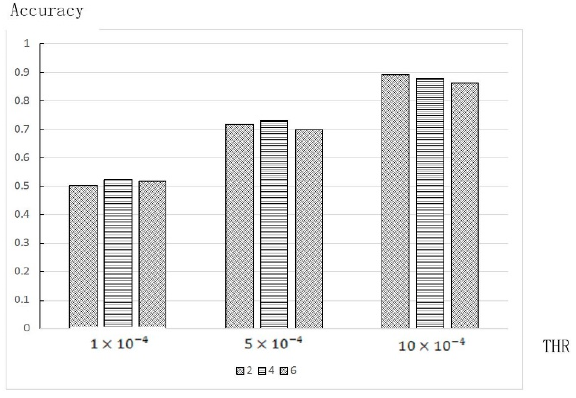
Figure 5. Accuracy rates of the Mahalanobis distance detection under different settings.